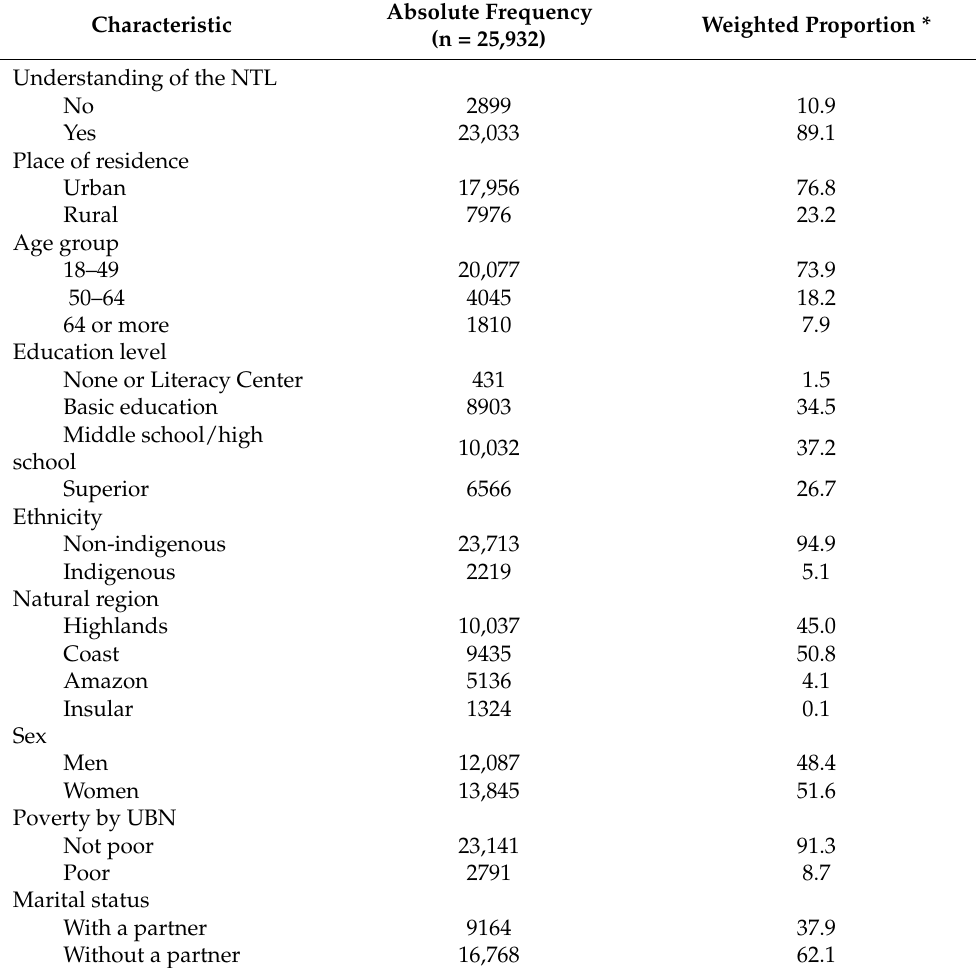
Table 1. Characteristics of the adult population of Ecuador included in the ENSANUT, 2018. Absolute Frequency Characteristic Weighted Proportion * (n = 25,932) Understanding of the